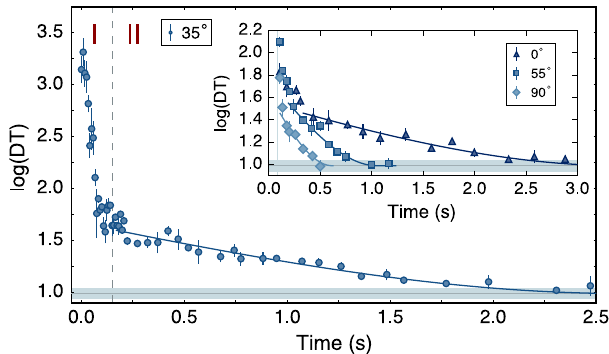
FIG. 3. The full θ ¼ 35 ° evolution showing the boundary between regime I and regime II. The solid blue line is fit to the data between the beginning of regime II [log ð DT Þ ≈ 1 . 5 ] and the noise floor [log ð DT Þ ¼ 1 ]. Vertical bars indicate standard error. The light blue horizontal band is the standard uncertainty of the noise floor. The inset contains regime II decay results for the same angles as in Figs. 2(c) –